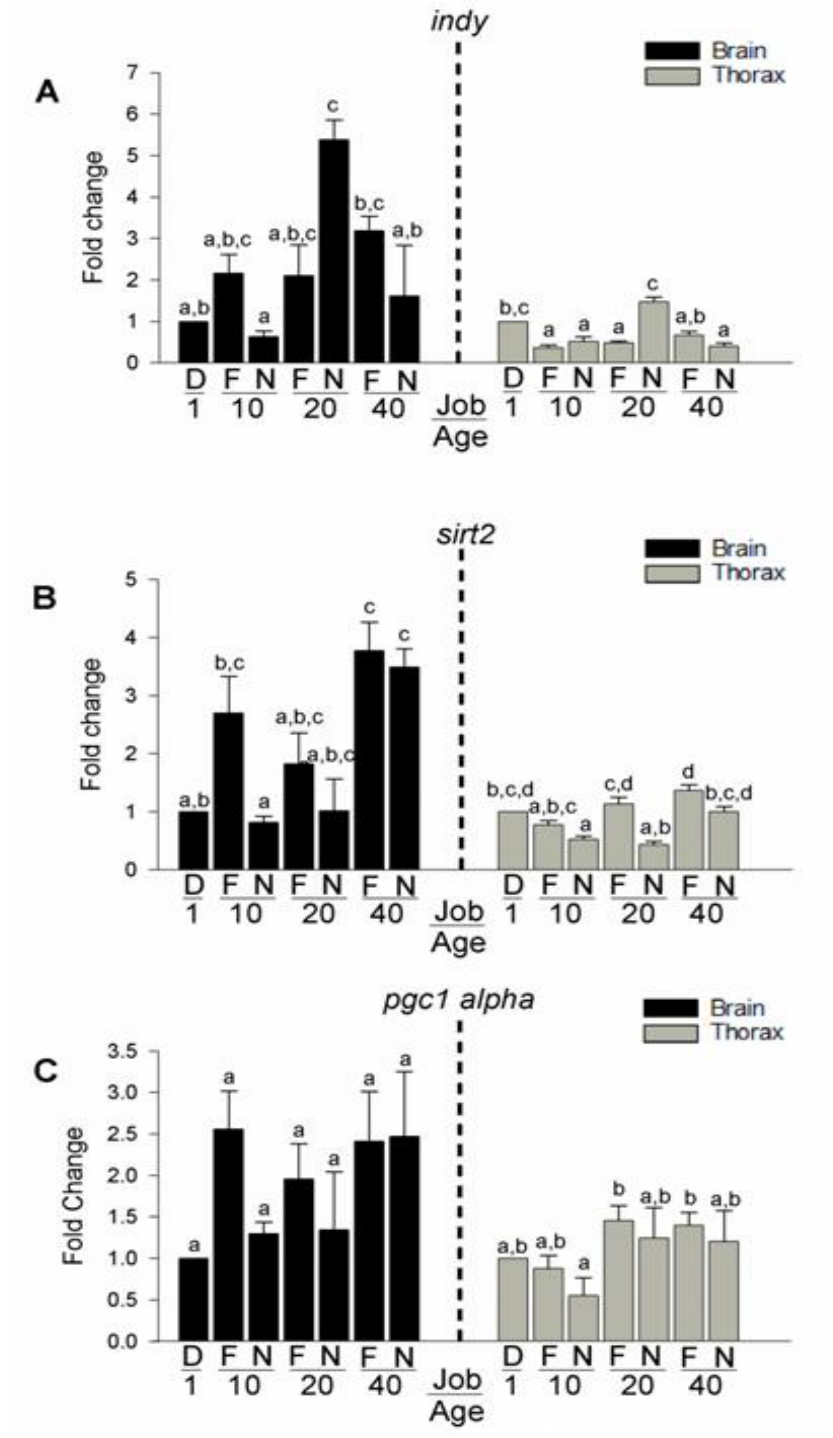
Figure 7. Expression of longevity mediating transcripts in A. mellifera flight muscle and brain. mRNA levels of putative genes involved in aging/senescence were measured in brain tissue and flight muscle. Expression of ( A ) indy , ( B ) sirt2 , and ( C ) pgc1alpha revealed distinct expression patterns both between tissues and within tissues. D = single day old bee; N = nurse; F = forager. Fold change represents the relative difference compared to one day old